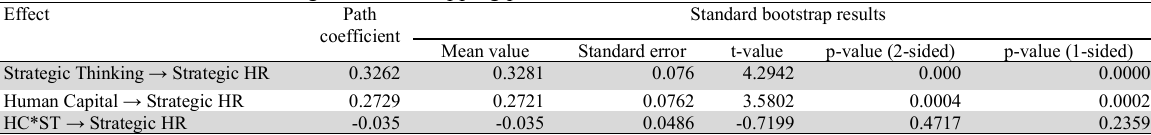
The results of the first model using PLS bootstrapping